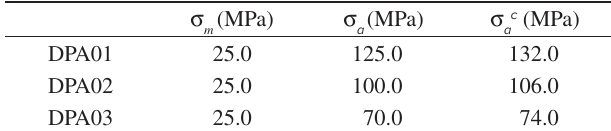
Table 3. Full-scale test nominal loadings.